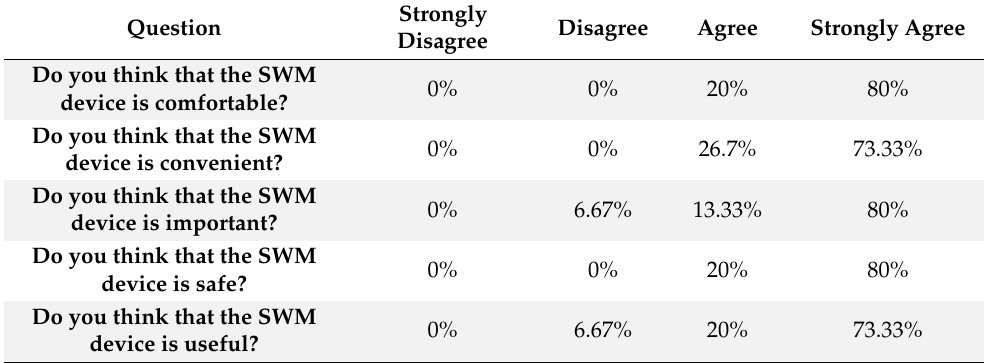
Table 5. Responses of the survey of user perception from participants ( n = 5).